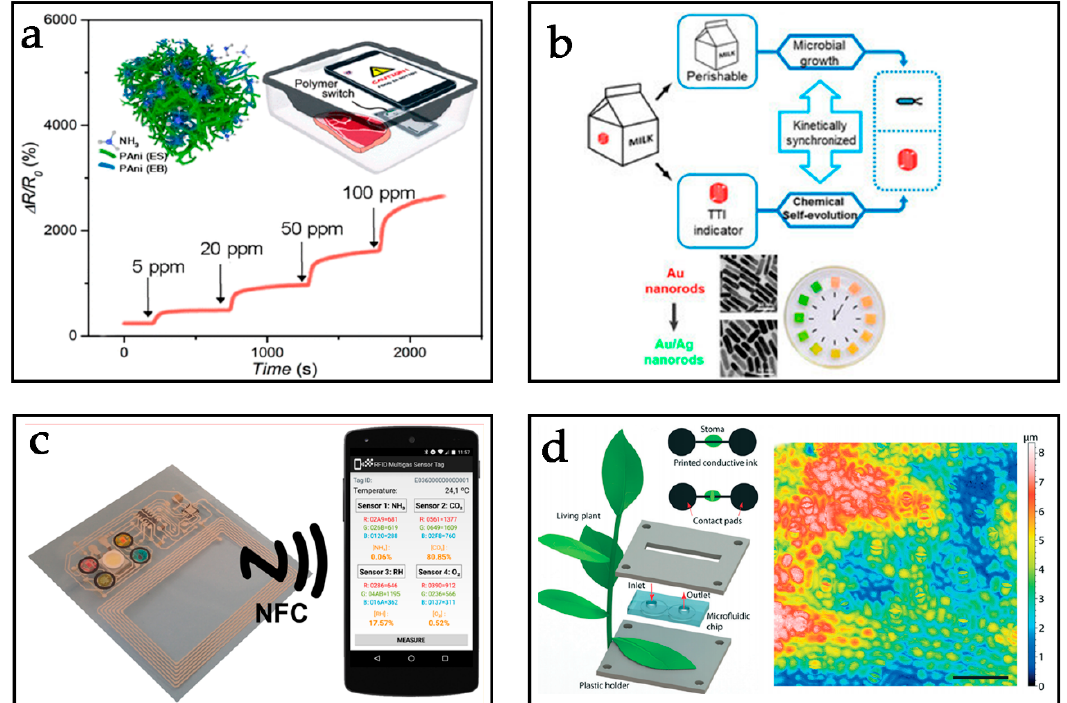
Figure 5. Other representative applications of NFC sensors. ( a ) Highly sensitive, printable nanostructured conductive polymer wireless sensor for food spoilage detection. Reprinted with permission from ref. [23]. ( b ) Schematic illustrating the expected “biochemo” synchronicity. Reprinted with permission from ref. [112]. ( c , d ) Plants growth monitoring. Reprinted with permission from ref. [24].